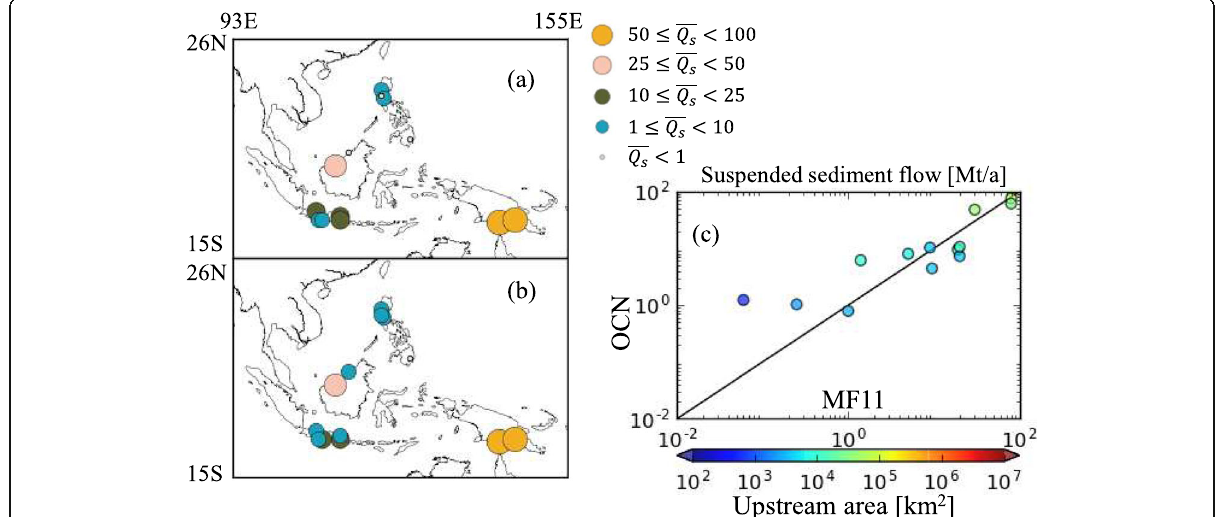
Fig. 10 Comparison of suspended sediment flow [Mt/a] between MF11 and OCN simulation a MF11 b OCN, and c scatter